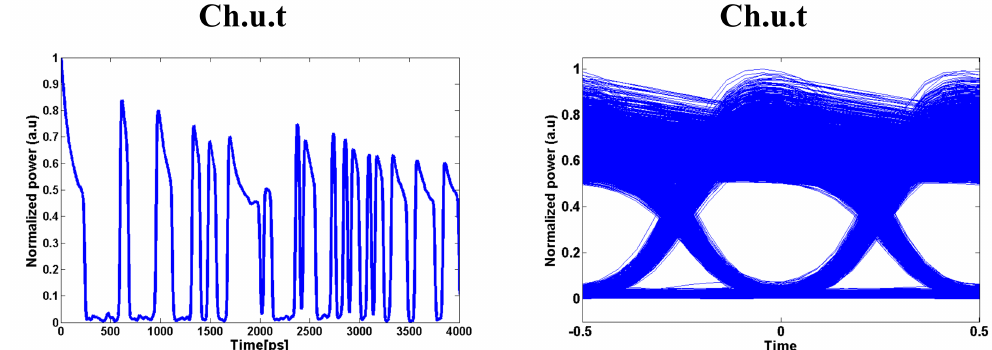
Figure 9. Simulated output data pattern and eye diagram for the Ch.u.t. with very high input power ( − 4 dBm per